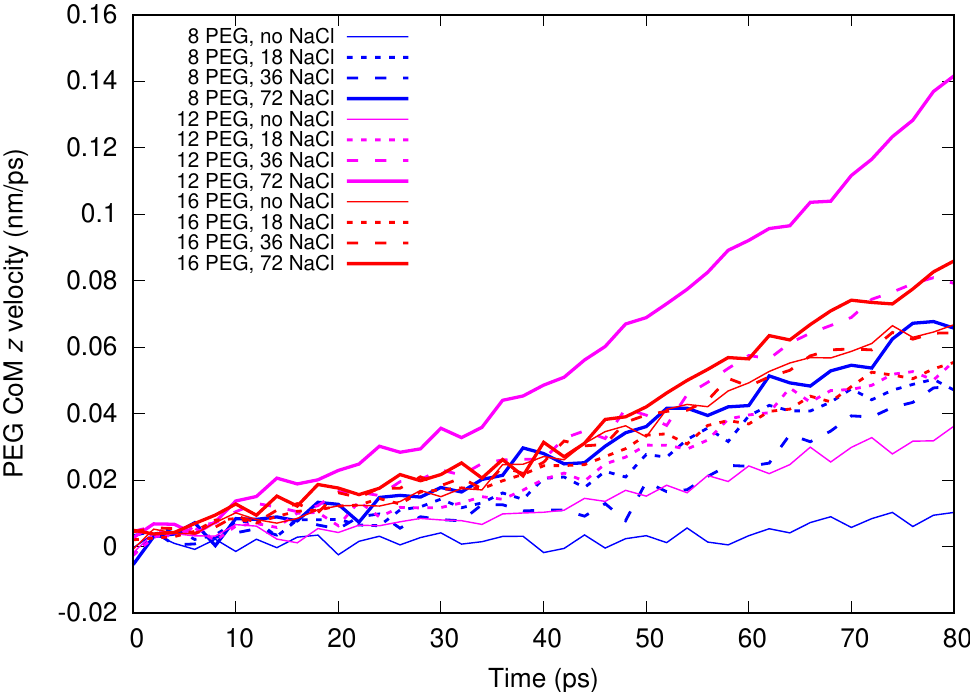
Figure 18. The z -component of the velocity of PEG’s center of mass as a function of production time for samples with 5.26-kDa PEG chains under 1.5 V/nm. Curves correspond to different numbers of PEG chains and NaCl ion pairs, see the legend. Plotted with gnuplot